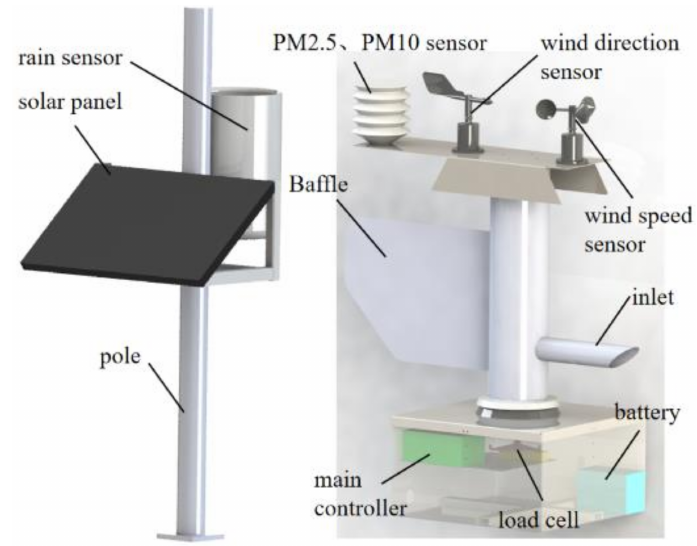
Figure 4. Structure diagram of farmland dust online monitoring system.